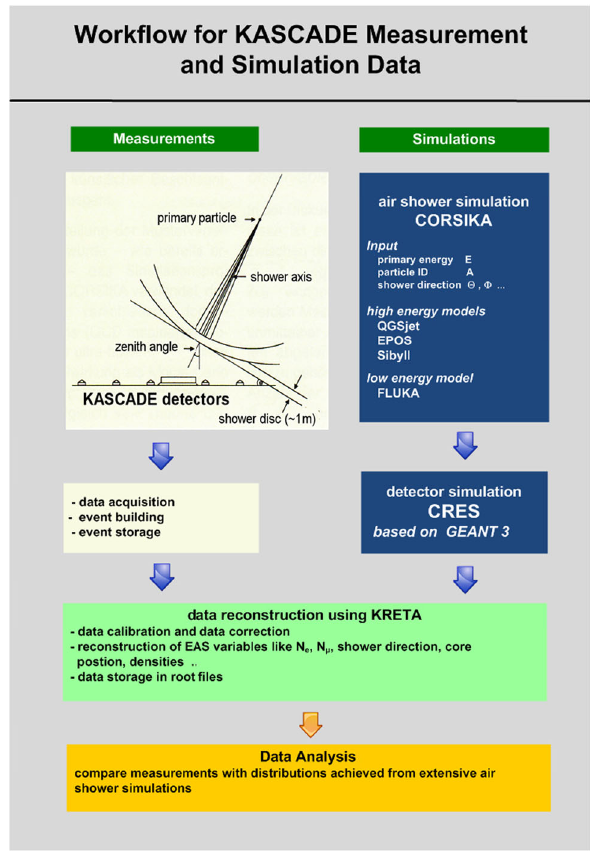
Fig. 9 KASCADE data analysis workflow for measurements and sim- ulations